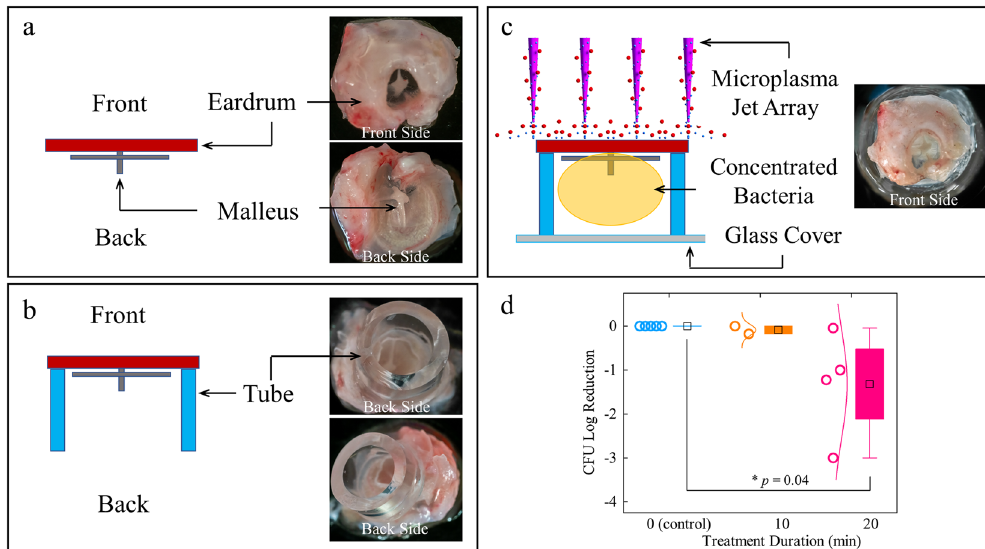
Fig. 2 A middle ear phantom model using an extracted rat eardrum. a A freshly harvested rat eardrum (front and back). b Plastic tubing adhered to the backside of the rat eardrum to generate a middle ear cavity-mimicking space. c Bacterial suspension was contained in the closed middle ear cavity. d Plot of CFU log reduction with microplasma treatment